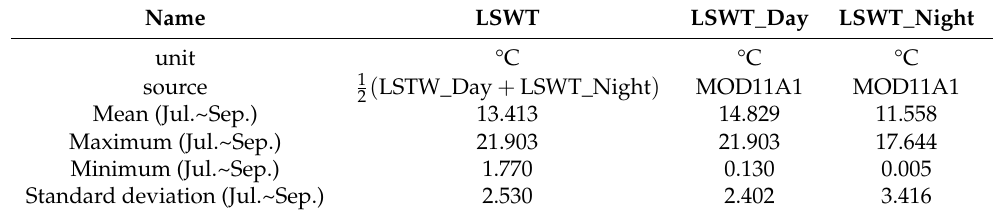
Table 1. Data sources and attributes of LSWT.